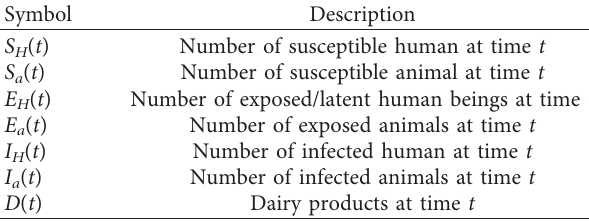
Figure 1: Model flow diagram. Table 1: Model variables description.